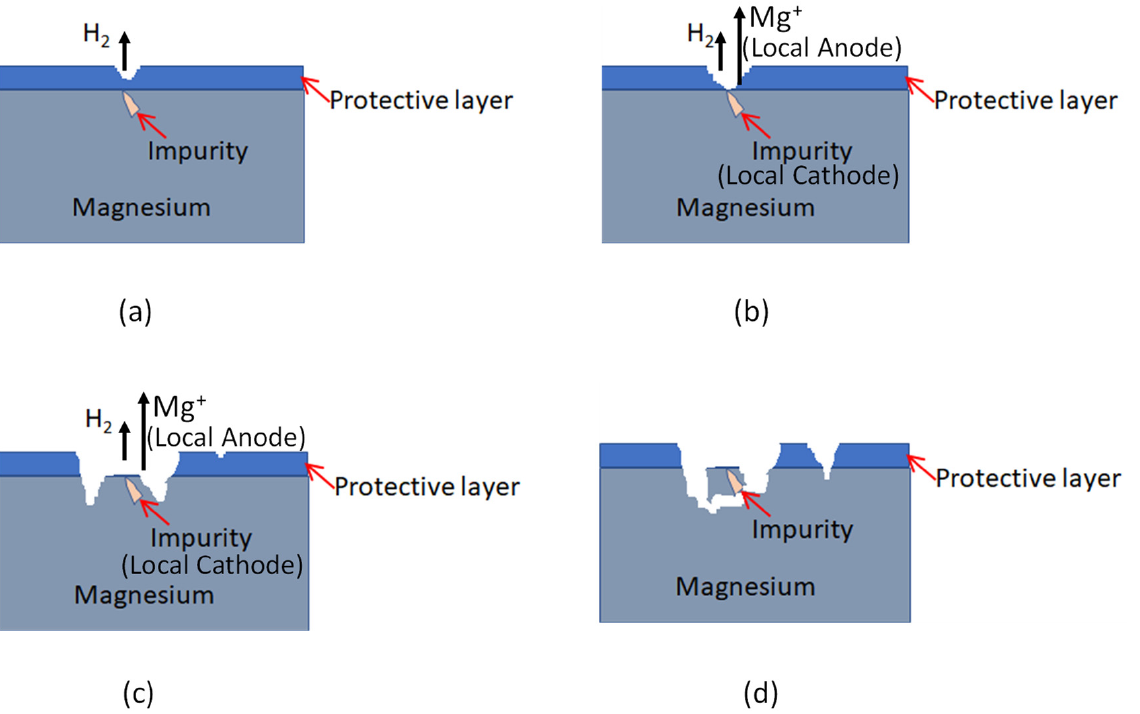
Figure 1. The localized corrosion mechanism of magnesium in aqueous media; ( a ) corrosion in regions with cracks in the passive layer or the vicinity of impurities; ( b ) there is an increase in immersion time, the passive layer is removed in a localized region, resulting in the formation of local anodes and cathodes on the surface; ( c ) after a long period of immersion; ( d ) a high degree of localized corrosion occurs, with additional mass loss due to the detachment of particles due to erosion.